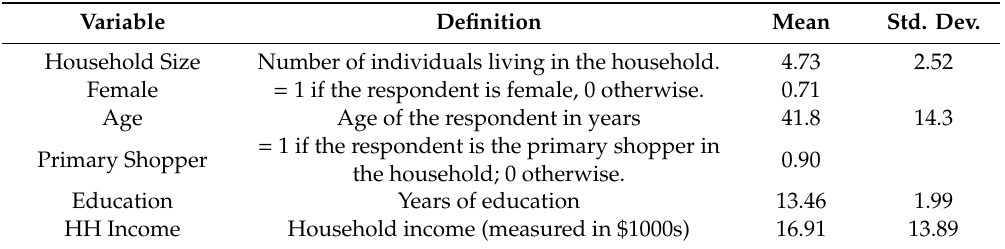
Table 1. Summary statistics of participants in the choice experiment.